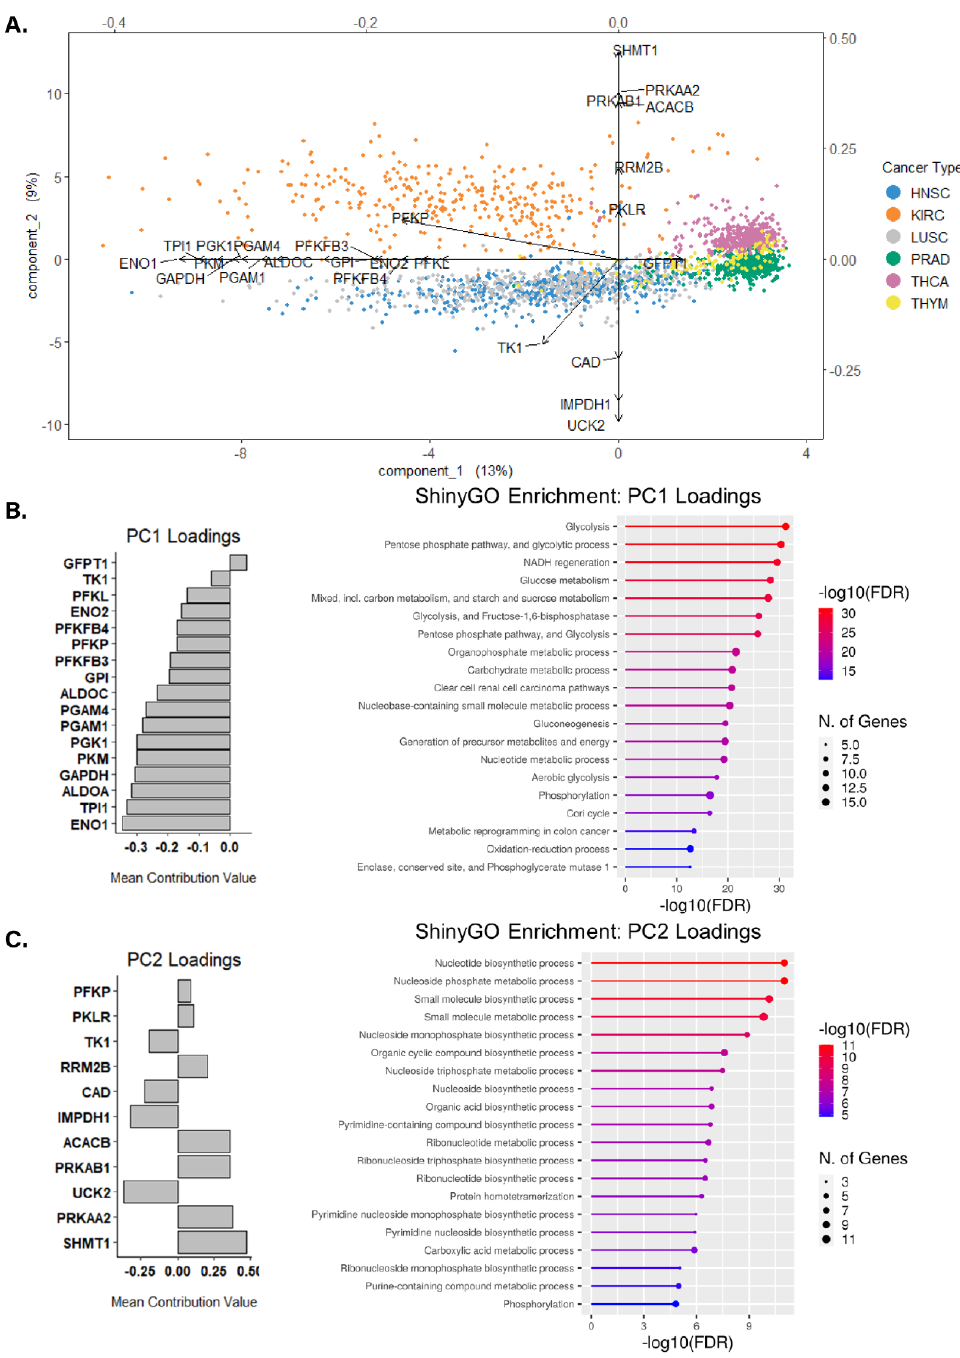
Figure 3. ( A ) sPCA of pan-cancer gene set transcript profiles. Biplot of unsupervised clustering for two components of the final sPCA result along with PC1-2 loadings. ( B , C ) ShinyGO enrichment of PC1-2 loading gene sets. ( B ) PC1 loadings comprise almost entirely of genes involved in glycolysis. PC1 loadings contribute to the enrichment of glycolysis, cellular redox, and metabolic reprogramming pathways, in addition to diverse biosynthetic pathways. ( C ) PC2 loadings comprise of genes involved in nucleotide metabolism and AMPK signaling, with the most significantly enriched pathways relating to nucleotide metabolism.